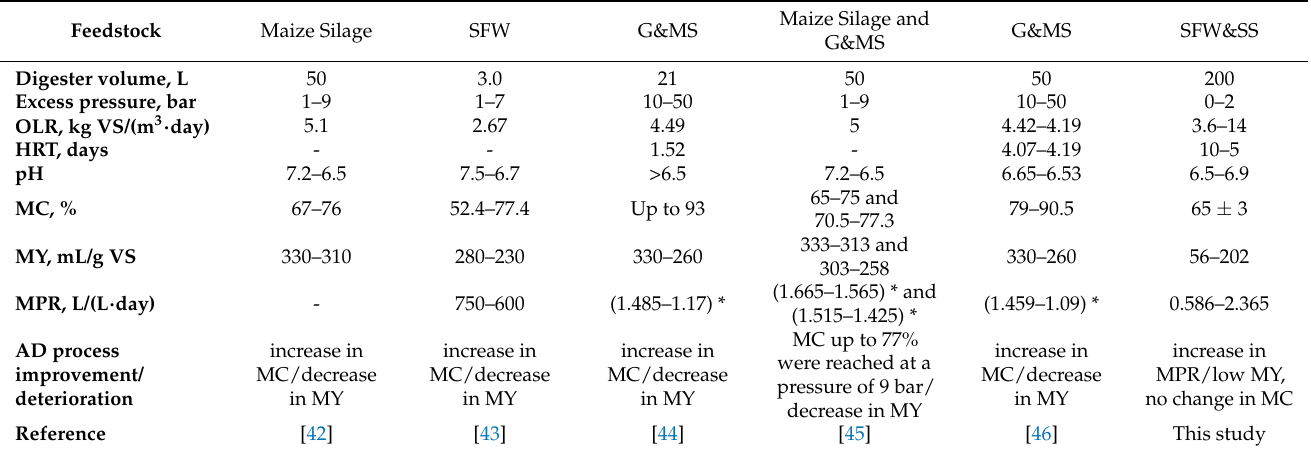
Table 3. Comparison of AD performance using pressurized